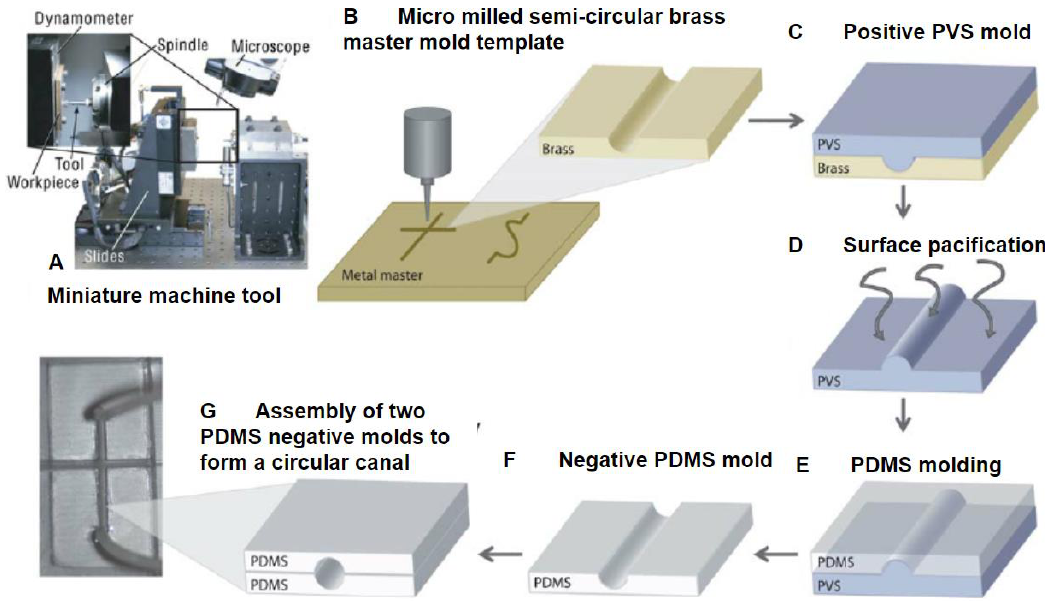
Figure 5. ( A ) Miniature machining tool used for micromilling ( B ) Micromilled master template for soft lithography ( C ) Using Poly-vinylsiloxane (PVS) to create a positive mold ( D ) Passivation of surface to prevent sticking ( E ) soft lithography with PDMS ( F , G ) assembly of two PDMS molds to create a channel. Adapted from Wilson et al [71] .